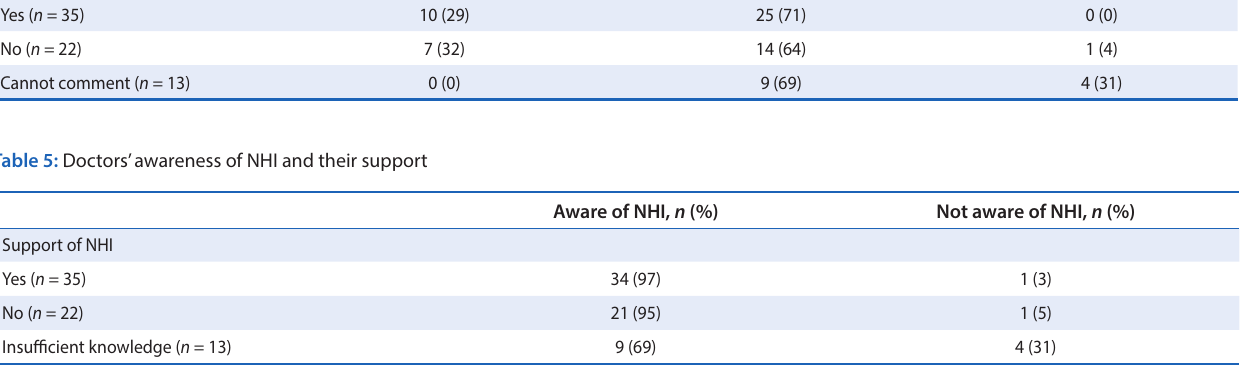
Table 4: Knowledge of doctors and their support ( n = 70; p < 0.05) Support for NHI